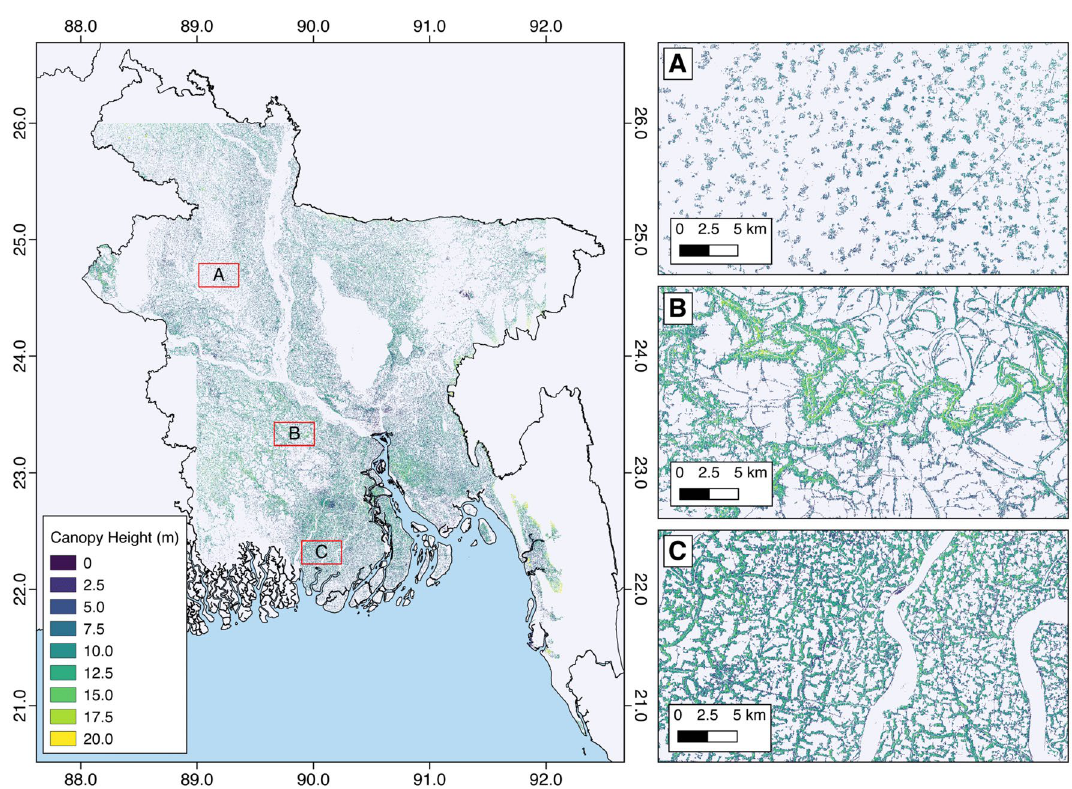
Figure 4. Distribution of TOF heights in Bangladesh. ( A ) Small heights surrounding homestead farms and dwellings ( B ) Larger TOF heights in natural stands along rivers. Larger trees are at the center of the stand and decrease towards the stand margin ( C ) Tree heights in anthropogenically managed TOF stands that line field boundaries. TOF stands on elevated terrain were omitted, alongside continuous forests and mangroves. Map made with QGIS 2.8 (https:// www. qgis. org/ en/ site/ index.